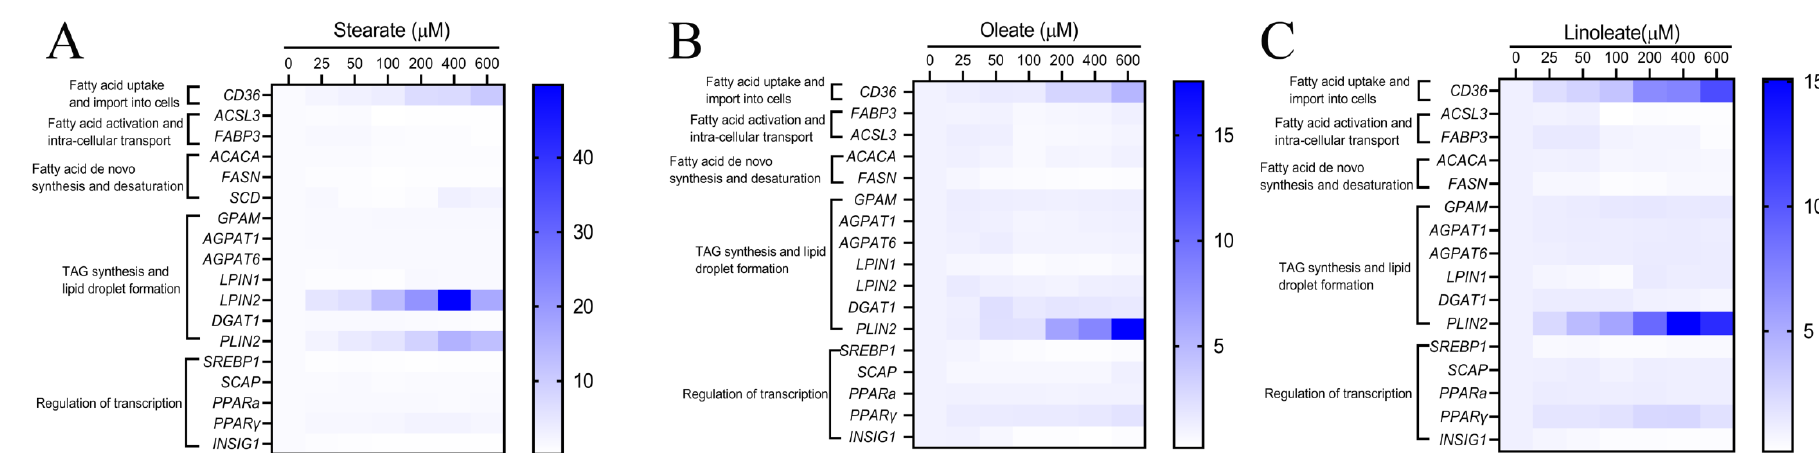
Figure 4. Representation of q PCR experimental data on mRNA expression of genes involved in lipid synthesis in pMECs. pMEC cells were incubated with 0 (control), 25, 50, 100, 200, 400 and 600 μM stearate ( A ), oleate ( B ) and linoleate ( C ), respectively, for 24 h. ( A ) Heatmap showing the expression levels of genes in response to graded-stearate concentration. ( B ) Heatmap showing the expression levels of genes in response to graded-oleate concentration. ( C ) Heatmap showing the expression levels of genes in response to graded-linoleate concentration.